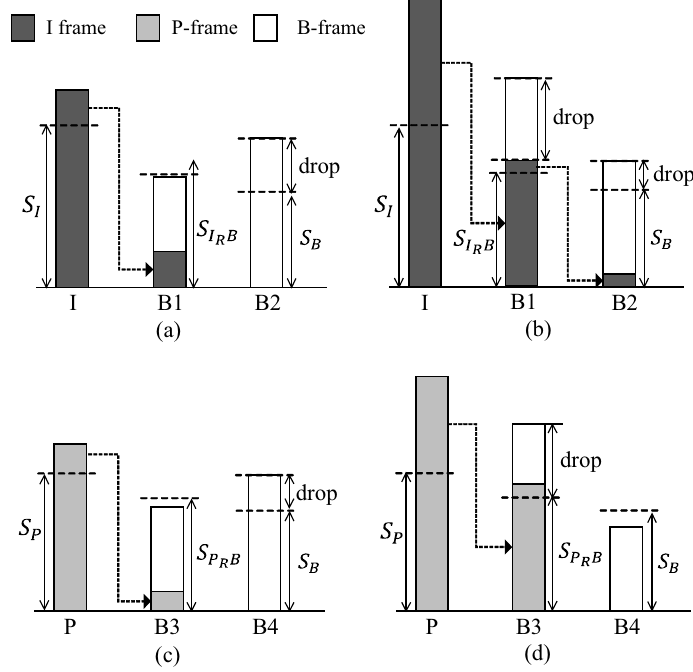
Figure 5. Transmission scheme according to the frame priority: ( a ) remaining I -frame is transmitted in the following B 1-frame; ( b ) remaining I -frame in the B 1 frame interval is again concatenated and transmitted in the B 2-frame; ( c ) remaining P -frame is transmitted in the following B 3-frame; ( d ) remaining P -frame in the B 3 frame interval is